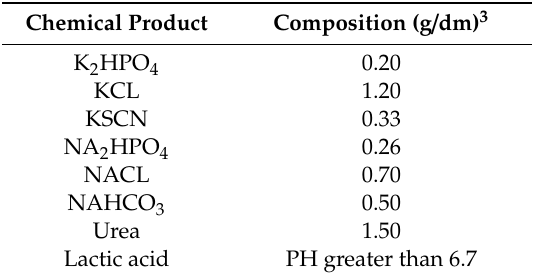
Table 4. Composition of artificial